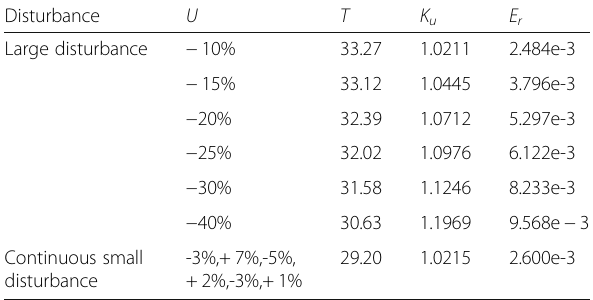
Fig. 5 Fitting curves of the model under large